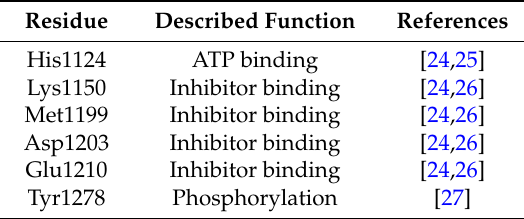
Figure 9. Root-mean-square fluctuation (RMSF) comparison of ALK–ATP complexes. Amino acid residues of crizotinib-associated (red line) or lorlatinib-associated (black line) ALK protein were analyzed for RMSF. Table 2. Experimentally identified critical amino acid resides of